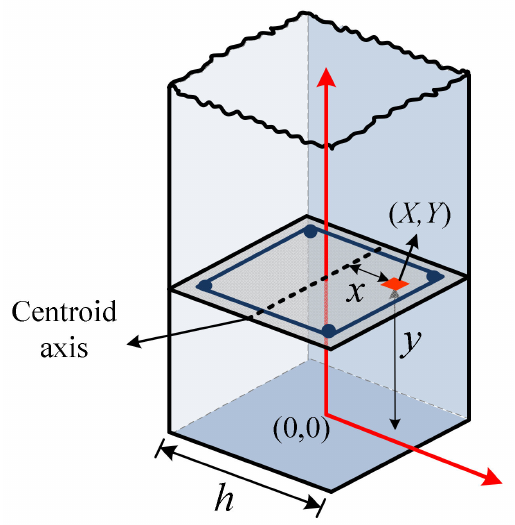
Figure 2. Schematic showing the material